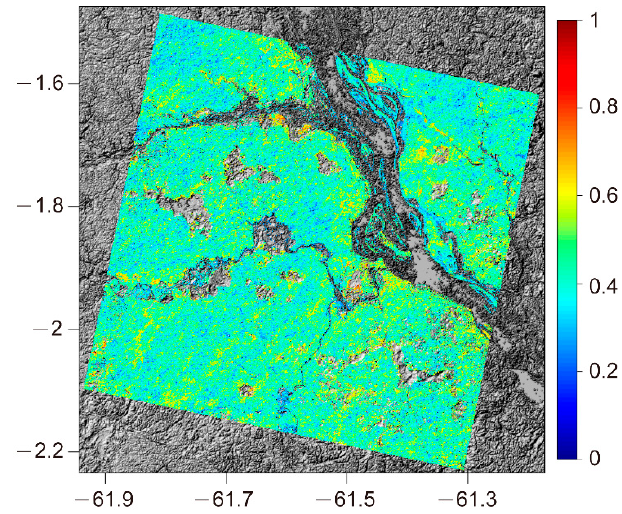
Figure 4. Coherence map superimposed on the base map of TanDEM-X digital elevation model (DEM). The cavities are non-forest areas.